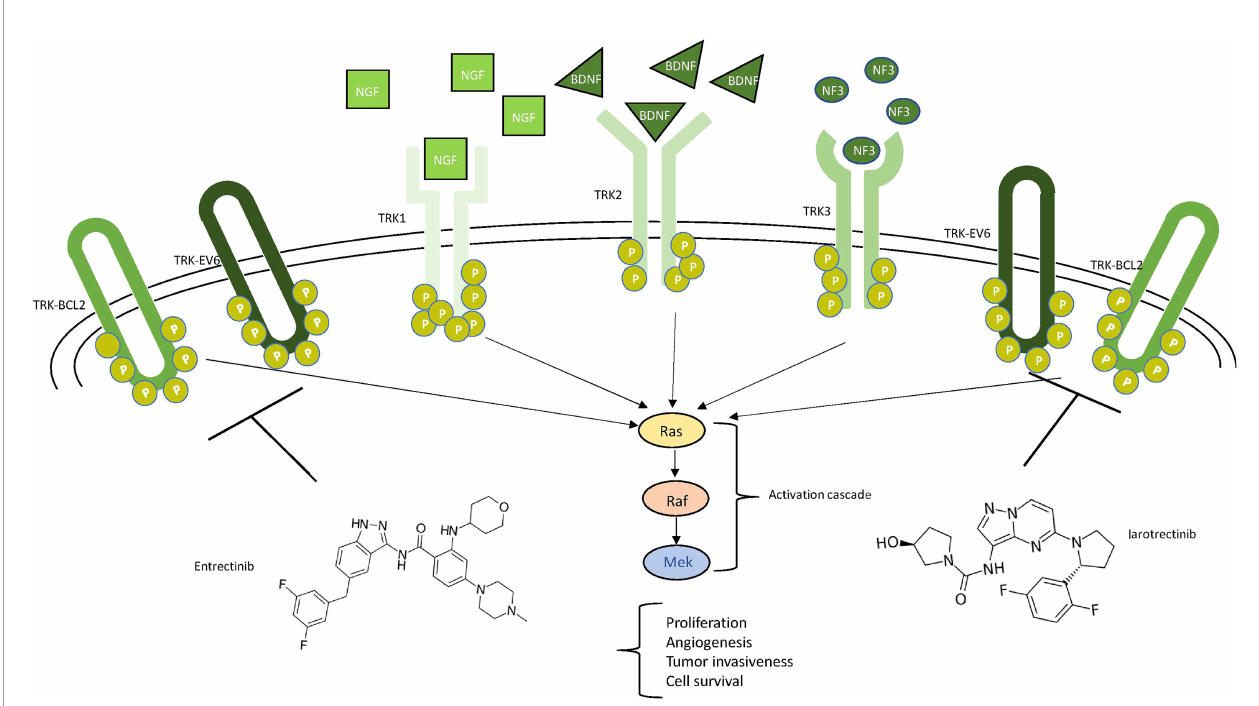
FIGURE 5 | Schematic view of NTRK signaling. Ligands (NGF in squares, BDNF in triangles, and NF3 in circles) and their respective receptors (TRK1/2/3) are represented. The main neurotrophic tyrosine receptor kinase (NTRK) fusion products (TRK-BCL1 and TRK-EV6) are represented as ellipticals as they do not need any ligand to be active. All the receptors trigger the MAPK pathway, leading to the indicated consequences. Two drugs, entrectinib and larotrectinib, can inhibit the NTRK aberrant forms as